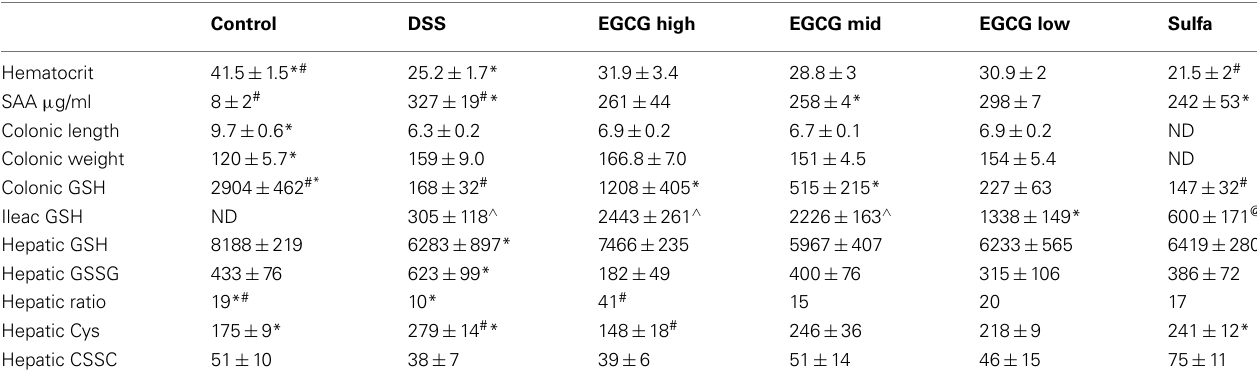
Table 1 | Comparison of inflammatory markers and antioxidants between sham normal controls, DSS-induced colitic animals, and those treated with dose escalating EGCG or